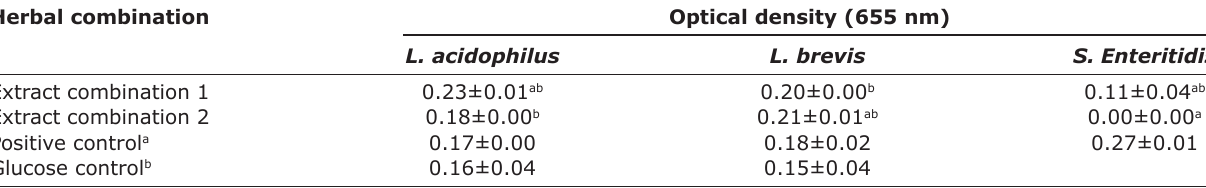
Table-5: Growth of L. acidophilus , L. brevis , and S . Enteritidis in media enriched with herbal extracts. Herbal combination